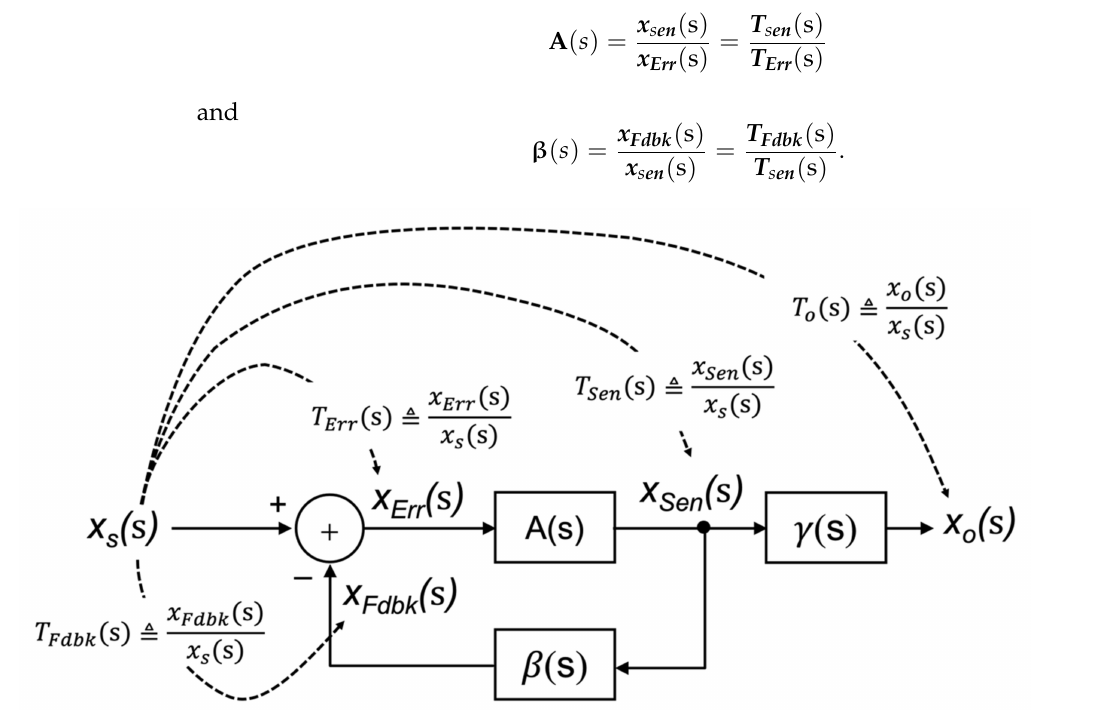
Figure 8. Illustrating the intermediate transfer functions associated with a single-loop feedback